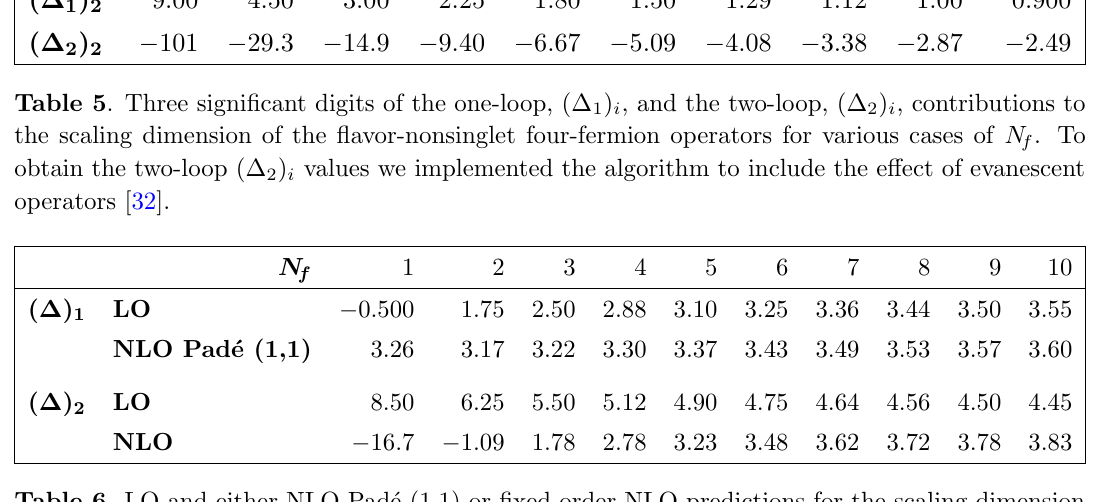
Table 6 . LO and either NLO Pad(cid:19)e (1,1) or (cid:12)xed-order NLO predictions for the scaling dimension of the two (cid:13)avor-nonsinglet four-fermion operators at d = 3 for various values of N f . Only three signi(cid:12)cant digits are being